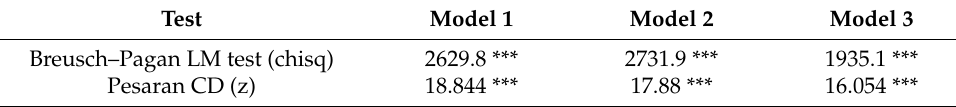
Table 3. Cross-sectional dependence empirics.